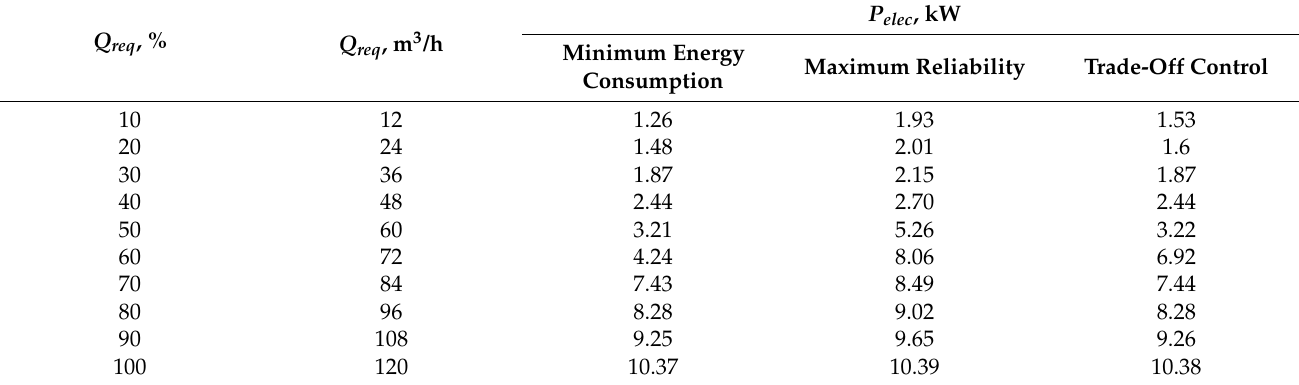
Table 7. Results of the electric power calculation in the pump system applying the different control methods. 3 Q req , % Q req , m